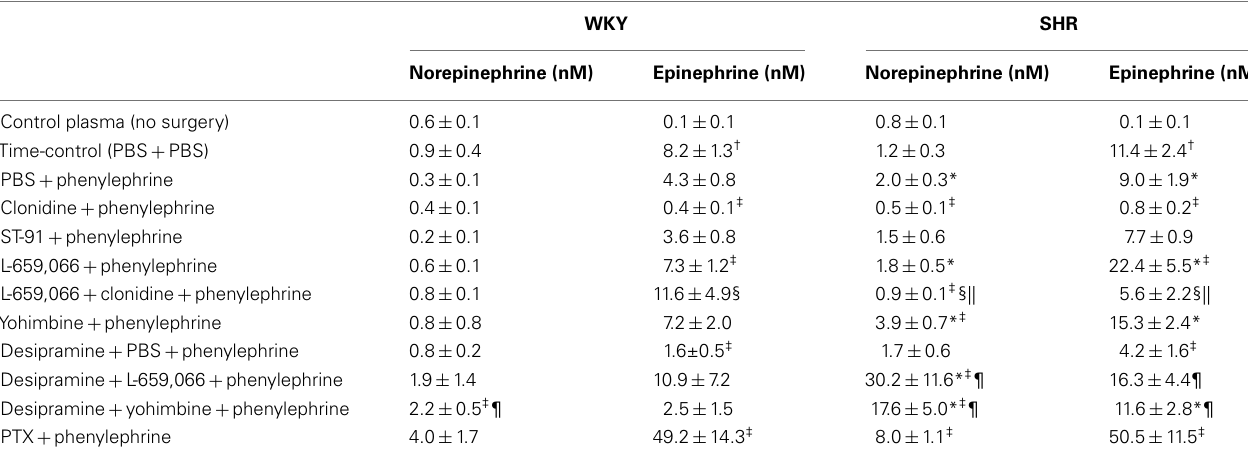
Table 1 |The plasma concentration of norepinephrine and